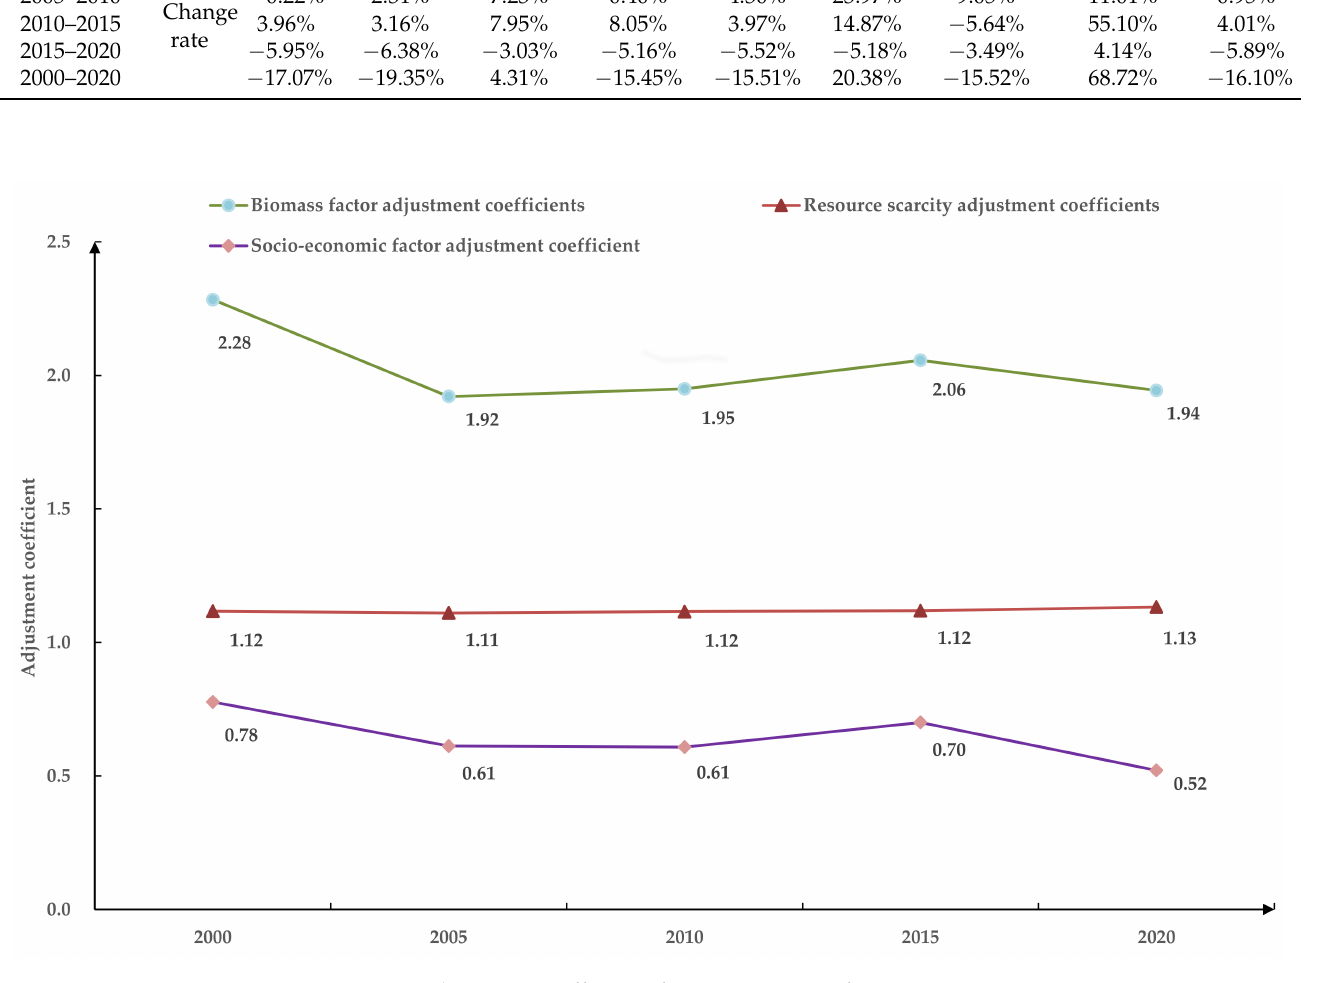
Figure 5. Adjustment coefficient of Hainan province from 2000 to